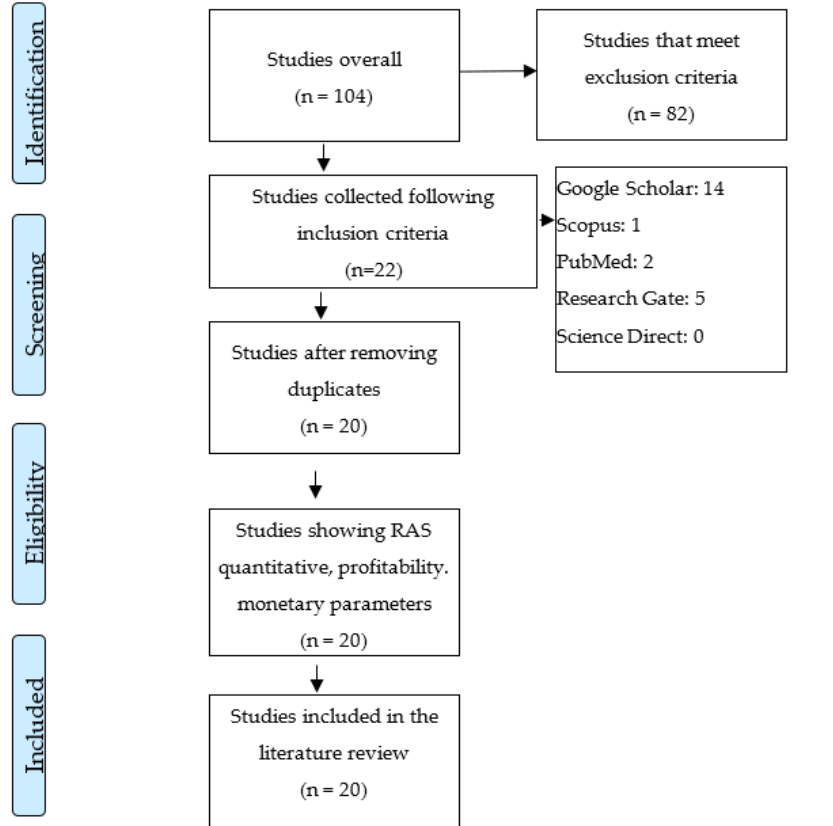
Figure 1. Flow diagram of literature review. Source: Authors.